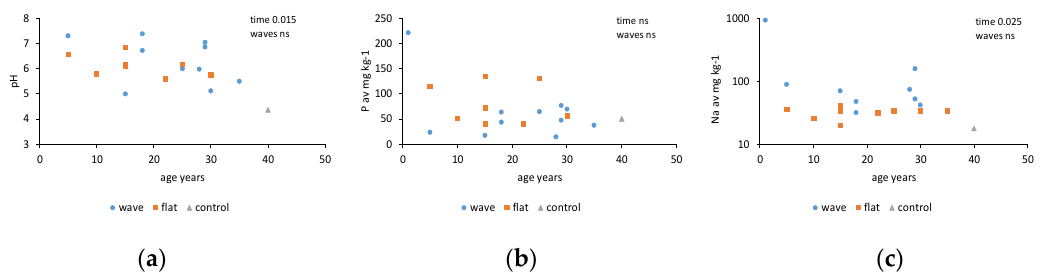
Figure 4. Chemical factors: ( a ) pH, ( b ) available phosphorus, and ( c ) sodium in postmining sites of various ages that were either levelled (flat) or not (wave). Control was a forest unaffected by mining; p values shown for effect of plot age (time) and presence of wavy surfaces (waves).